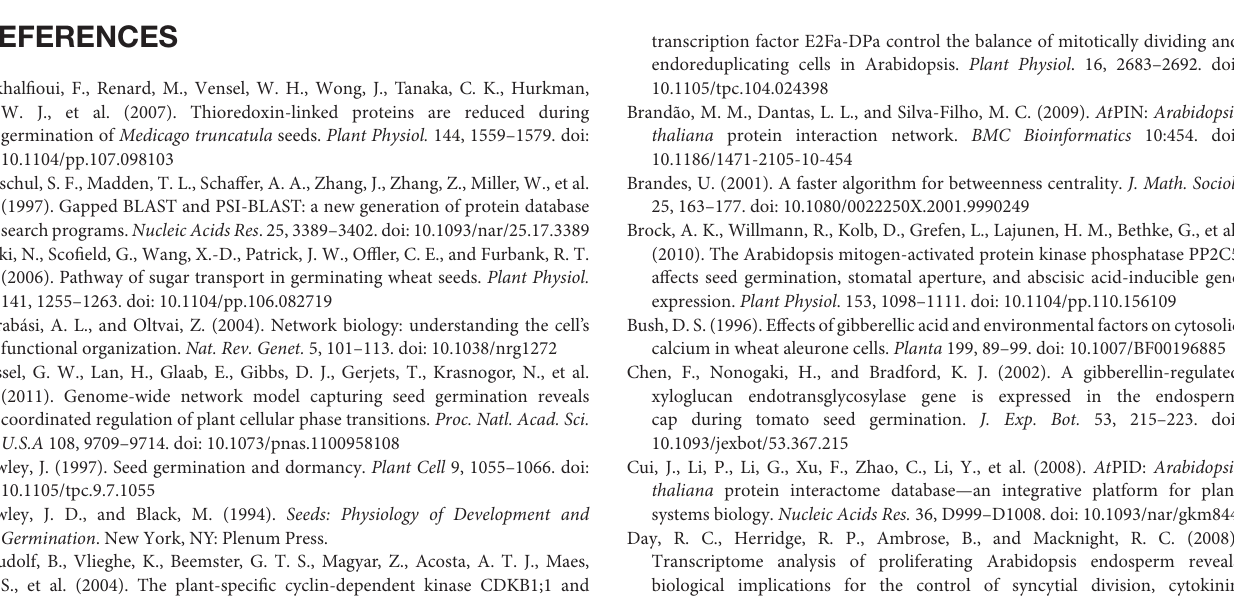
Table S1 | Details of differentially expressed proteins ( Podophyllum Germination Proteins; PGPs), identified through proteomic analysis, during seed germination in Podophyllum hexandrum Royle and their orthologs in Arabidopsis thaliana . Table S2 | Details of the predicted pairwise interactions among the Arabidopsis proteins. Table S3 | Nodes with Top50 values identified for each of the parameters; Closeness, Radialilty, Degree and betweenness (stress). For Top50 degree-values, 57 such nodes were obtained, whereas 50 nodes each were obtained for the remaining three parameters. Figure S1 | 2DE analysis of proteins of germinating seeds (late Phase II) as compared to un-germinated seeds (early Phase II) during germination. Marked spots indicate changes in the seed proteome of Podophyllum during radicle protrusion step. Figure S2 | Arabidopsis Protein Interaction Network ( At PIN) comprises of 96,827 protein interactions among 15,163 proteins (red). Orthologs of Arabidopsis were considered as functional equivalent representatives of PGPs and were mapped onto the At PIN. PGN comprises experimentally identified PGPs and proteins in their functional neighborhood that are reported as their direct interactors (Yellow). Figure S3 | Podophyllum Germination Network (PGN), comprising of 10,519 interactions among 1082 proteins, was constructed by extending the seed set of 68 (out of 88) Podophyllum germination proteins, obtained from proteomics studies, to include their interacting partners. Interactions reported for Arabidopsis thaliana (as represented in the At PIN) were used as a reference. The giant component comprising 10,466 interactions among 1028 proteins were used for the network